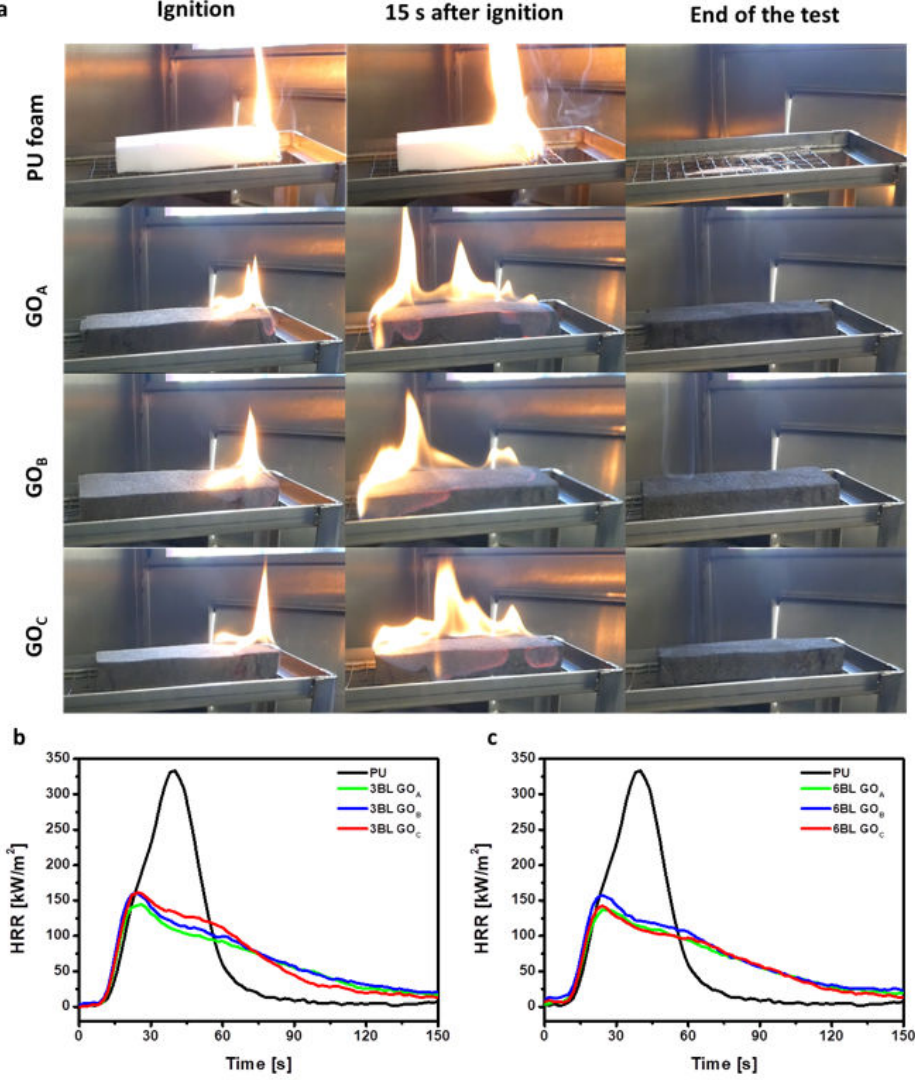
Figure 5. Flame retardant characterization: ( a ) Pictures of flammability test in horizontal configu- ration of untreated PU foam, 3BL CHIT/GO A treated PU foam, 3BL CHIT/GO B PU foam and 3BL CHIT/GO C PU foam. First column: right after ignition, second column: 15 s after ignition and third column: end of the test. ( b ) HRR vs time plots of 3BL samples. ( c ) HRR vs time plots of 6BL